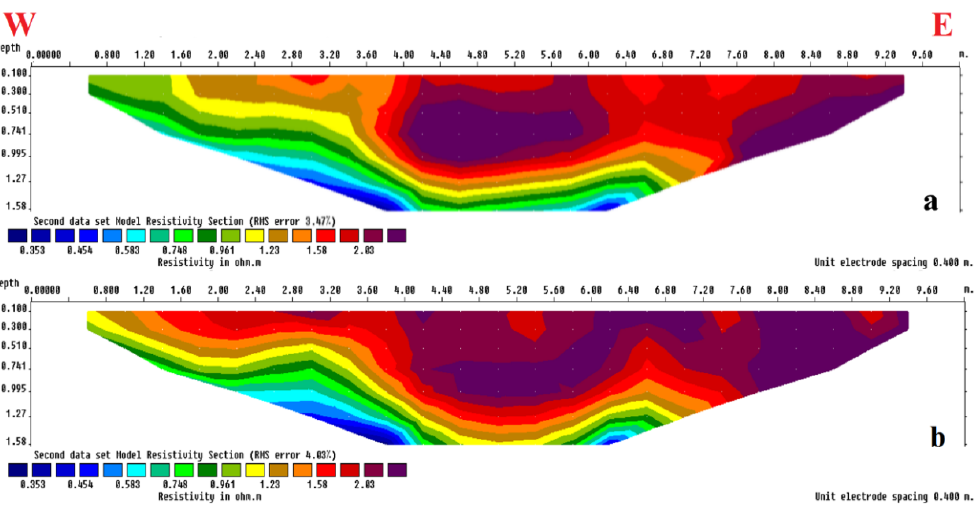
Figure 9. ERT models of the inverted apparent resistivity data measured along the same profile that was resurveyed in ( a ) December 2021 and ( b ) in April 2022.